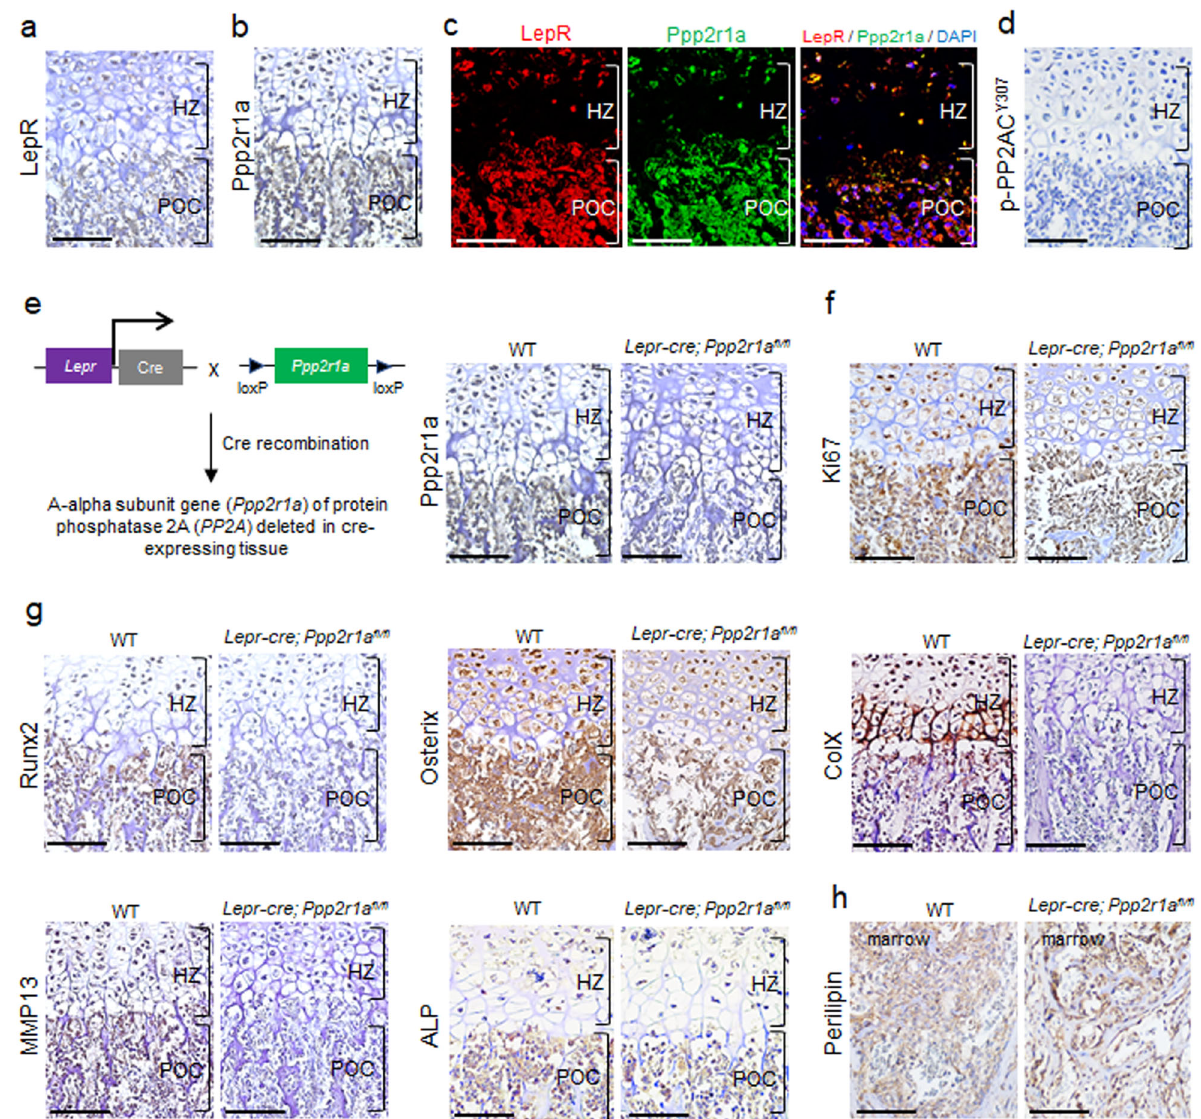
Fig. 3 Deletion of PP2A in LepR + MSCs inhibited proliferation and hypertrophic differentiation of POC in embryonic stage. Sections of E18.5 distal femur from Lepr-cre; Ppp2r1a fl / fl mice were subjected to immunostaining. a – d Immunohistochemistry (IHC) and immuno fl uorescence reveal that LepR + MSCs express Ppp2r1a and unphosphorylated (Y307) PP2AC in POC. a LepR IHC. b Ppp2r1a IHC. c Double immuno fl uorescence of LepR and Ppp2r1a. d Unphosphorylated (Y307) PP2AC IHC. e Illustration of conditional knockout of Ppp2r1a in LepR + MSCs. IHC reveals successful deletion of Ppp2r1a in LepR + MSCs in POC. IHC reveals that deletion of Ppp2r1a in LepR + MSCs leads to decreased expression of Ki67 ( f ) and hypertrophic markers, such as Runx2, Osterix, collagen X, MMP13 and alkaline phosphatase ( g ), and increased expression of Perilipin ( h ) in POC at E18.5. The rectangle box shows magni fi ed picture. HZ = Hypertrophic zone; POC = Primary ossi fi cation center; ColX = collagen X; ALP = alkaline phosphatase. Scale bar, 100 μ